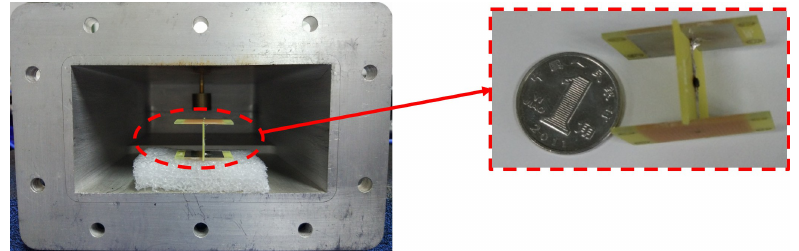
Figure 7. Views of fabricated ESF in waveguide.